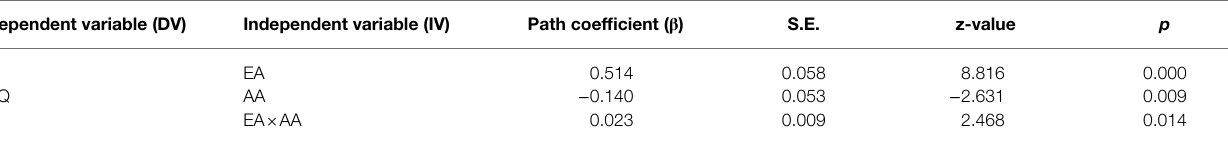
TABLE 7 | The analysis of moderating